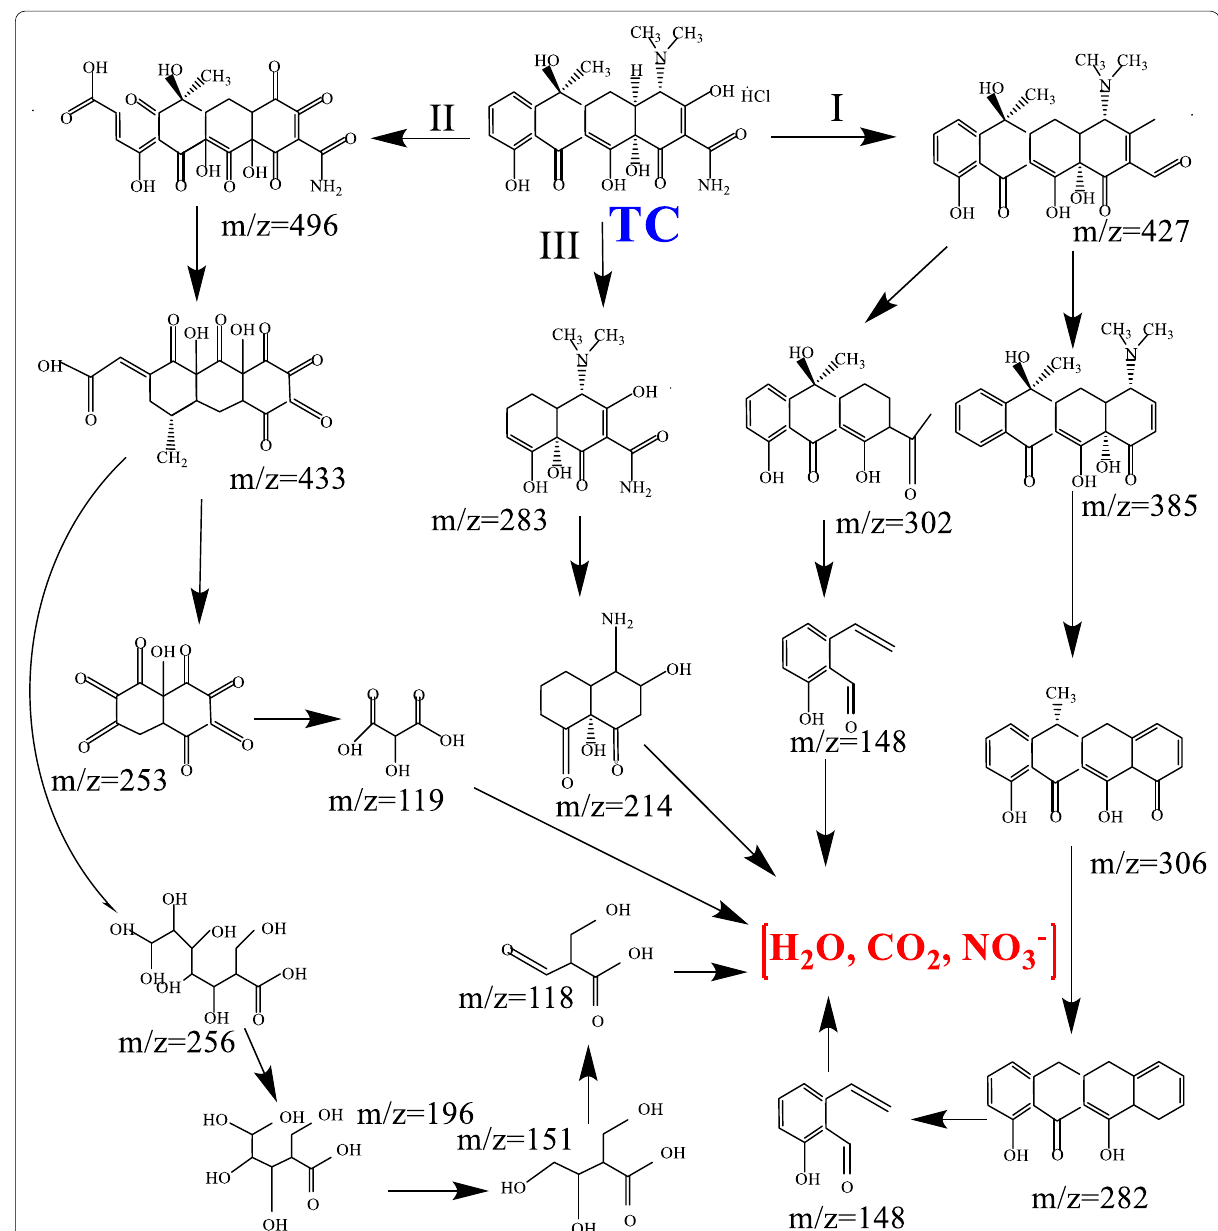
Fig. 8 The TC degradation pathway in simultaneous photocatalytic redox conversion of TC and Cr(VI) systems over